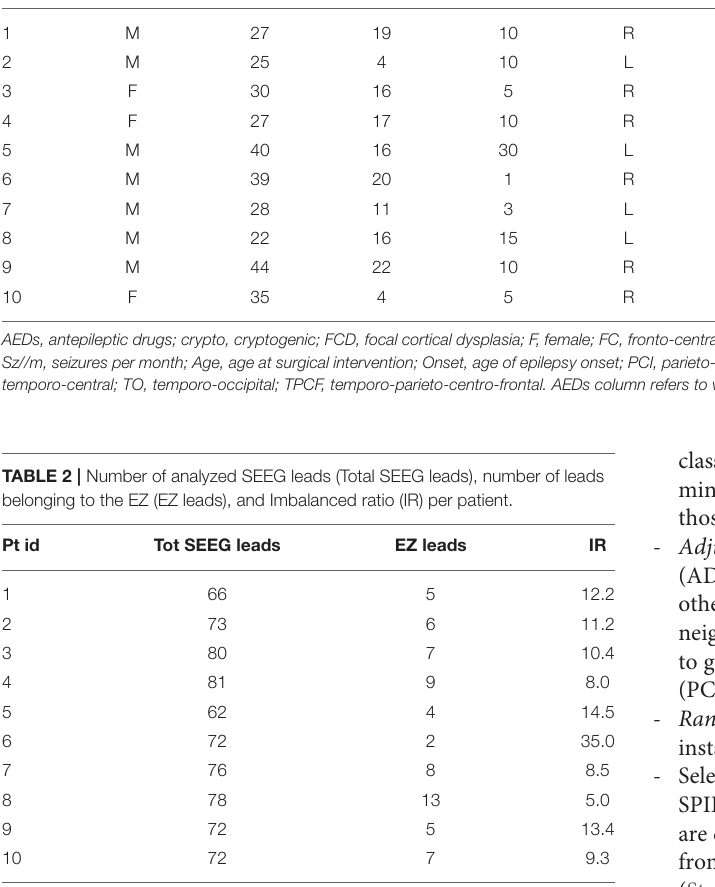
a proportion of 9:1, using features from nine patients for training and features from one single patient for test. For further statistical analysis, the same splitting was repeated for all the combinations of patients, thus providing 10 different training-testing